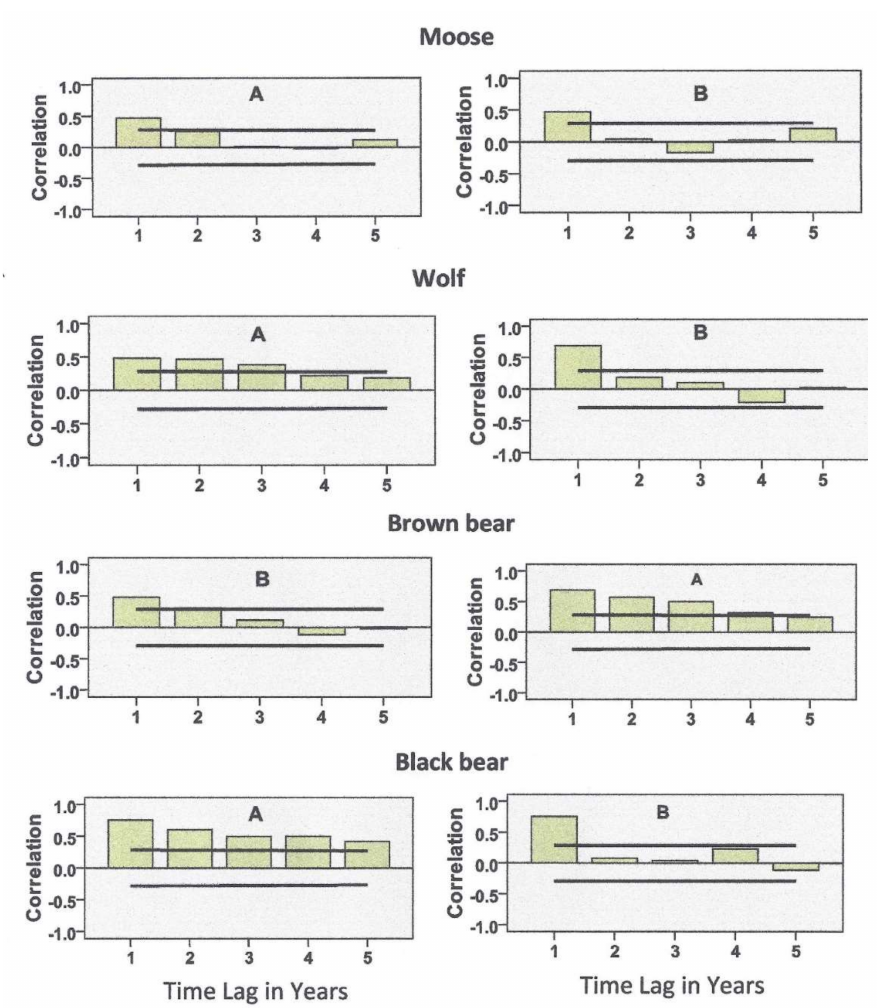
Figure 4. Autocorrelation (A) and partial autocorrelation (B) functions for time lagged (1–5 years) for moose, wolf, brown bear, and black bear harvest data from GMU 13 south-central Alaska, USA, 1973–2020. Correlations (bars) extending beyond bracketing lines are significant ( p ≤ 0.05). We only show lags up to 5 years because all significant correlations occurred within those